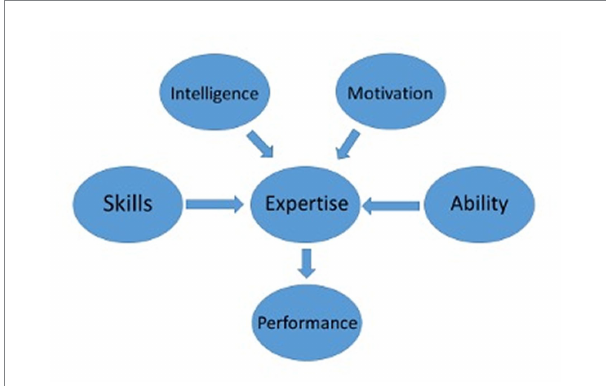
FIGURE 1 Conceptual model of the contributing factors of expertise and social performance, and their organization. Adapted from Ullen et al.